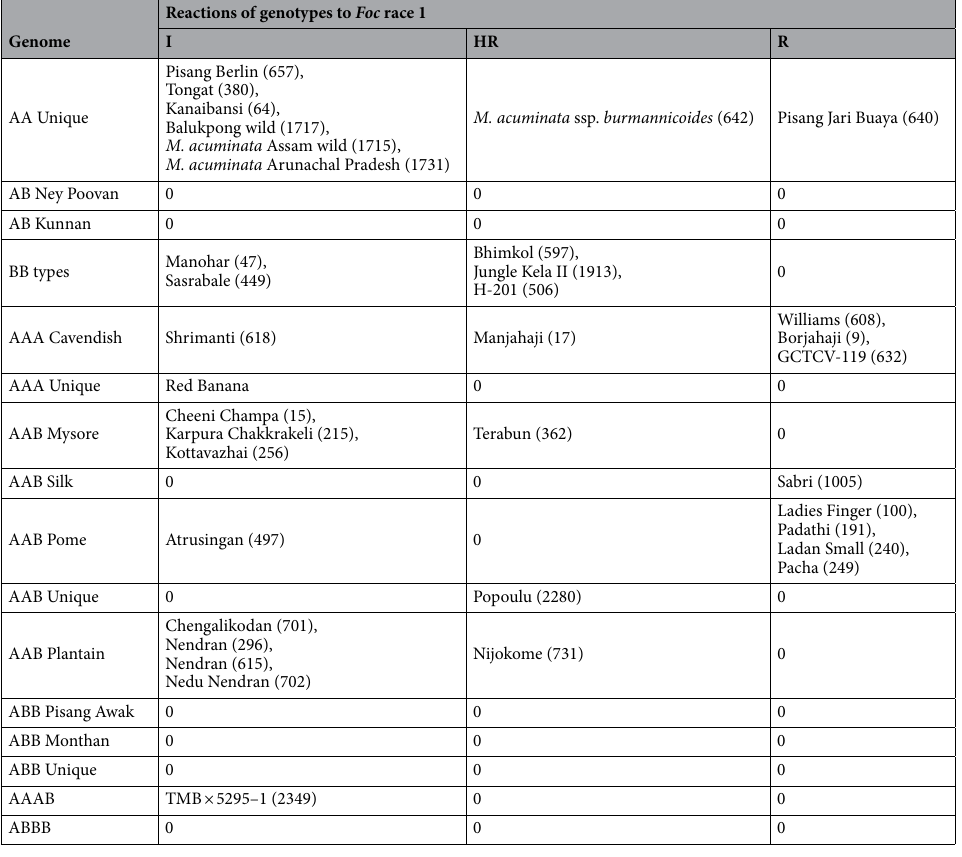
Table 4. Genotypes showing resistant reactions (immune, highly resistant and resistant reactions) to Foc race 1 (VCG 0124) common to both glasshouse and field conditions. I-Immune; HR-Highly resistant;